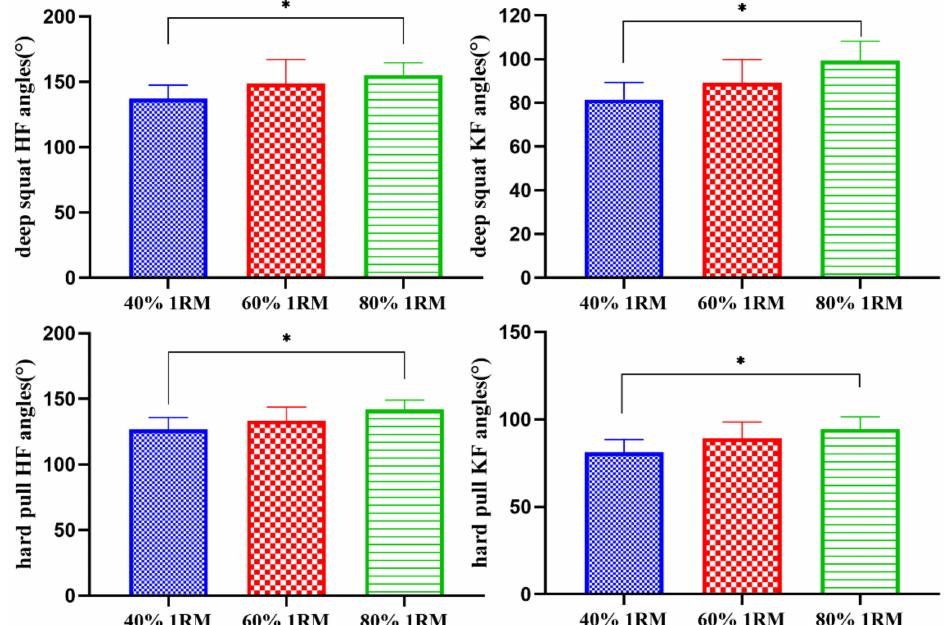
Figure 4. Comparisons of the different load intensity test angles ( ◦ ). * There was a significant difference between 40% 1RM (One repetition maximum testing) and 80% 1RM ( p <